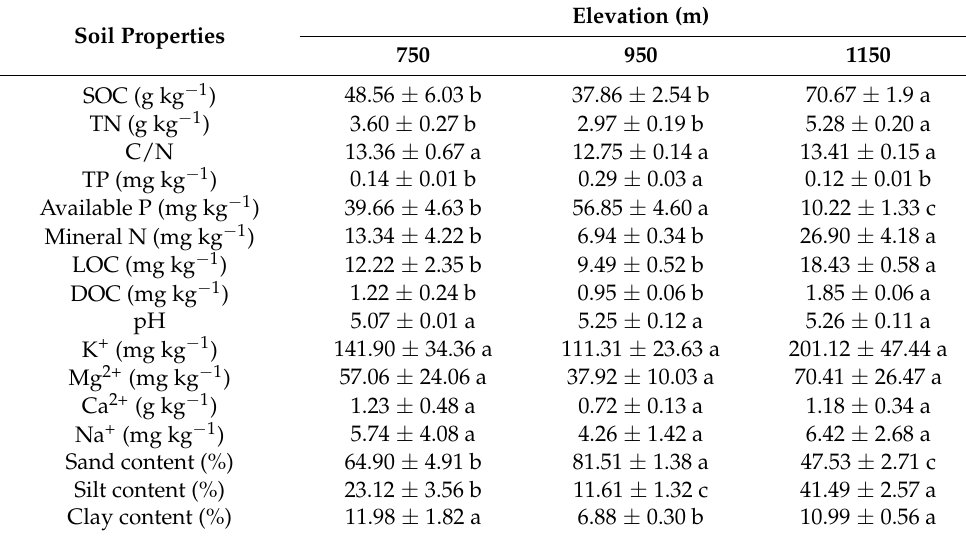
Table 1. Properties of soils at different elevations. The data are expressed as the means ± SE ( n = 4). Different letters followed data in the same row denote significant difference at p <